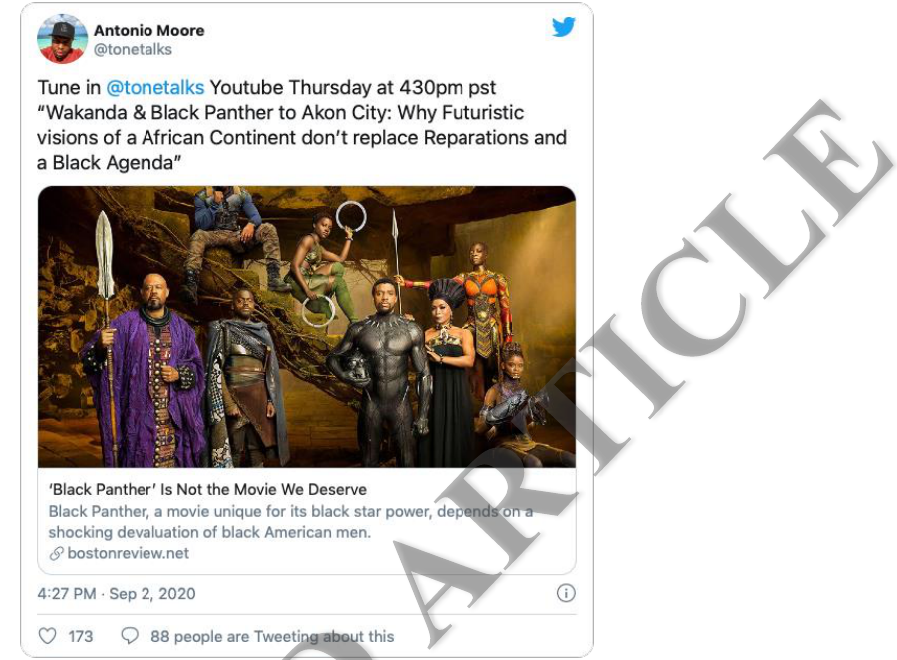
Figure 3. A tweet from Antonio Moore, linking to a commentary in the Boston Review that critiques the portrayal of Black Americans in the movie Black Panther, September 2,